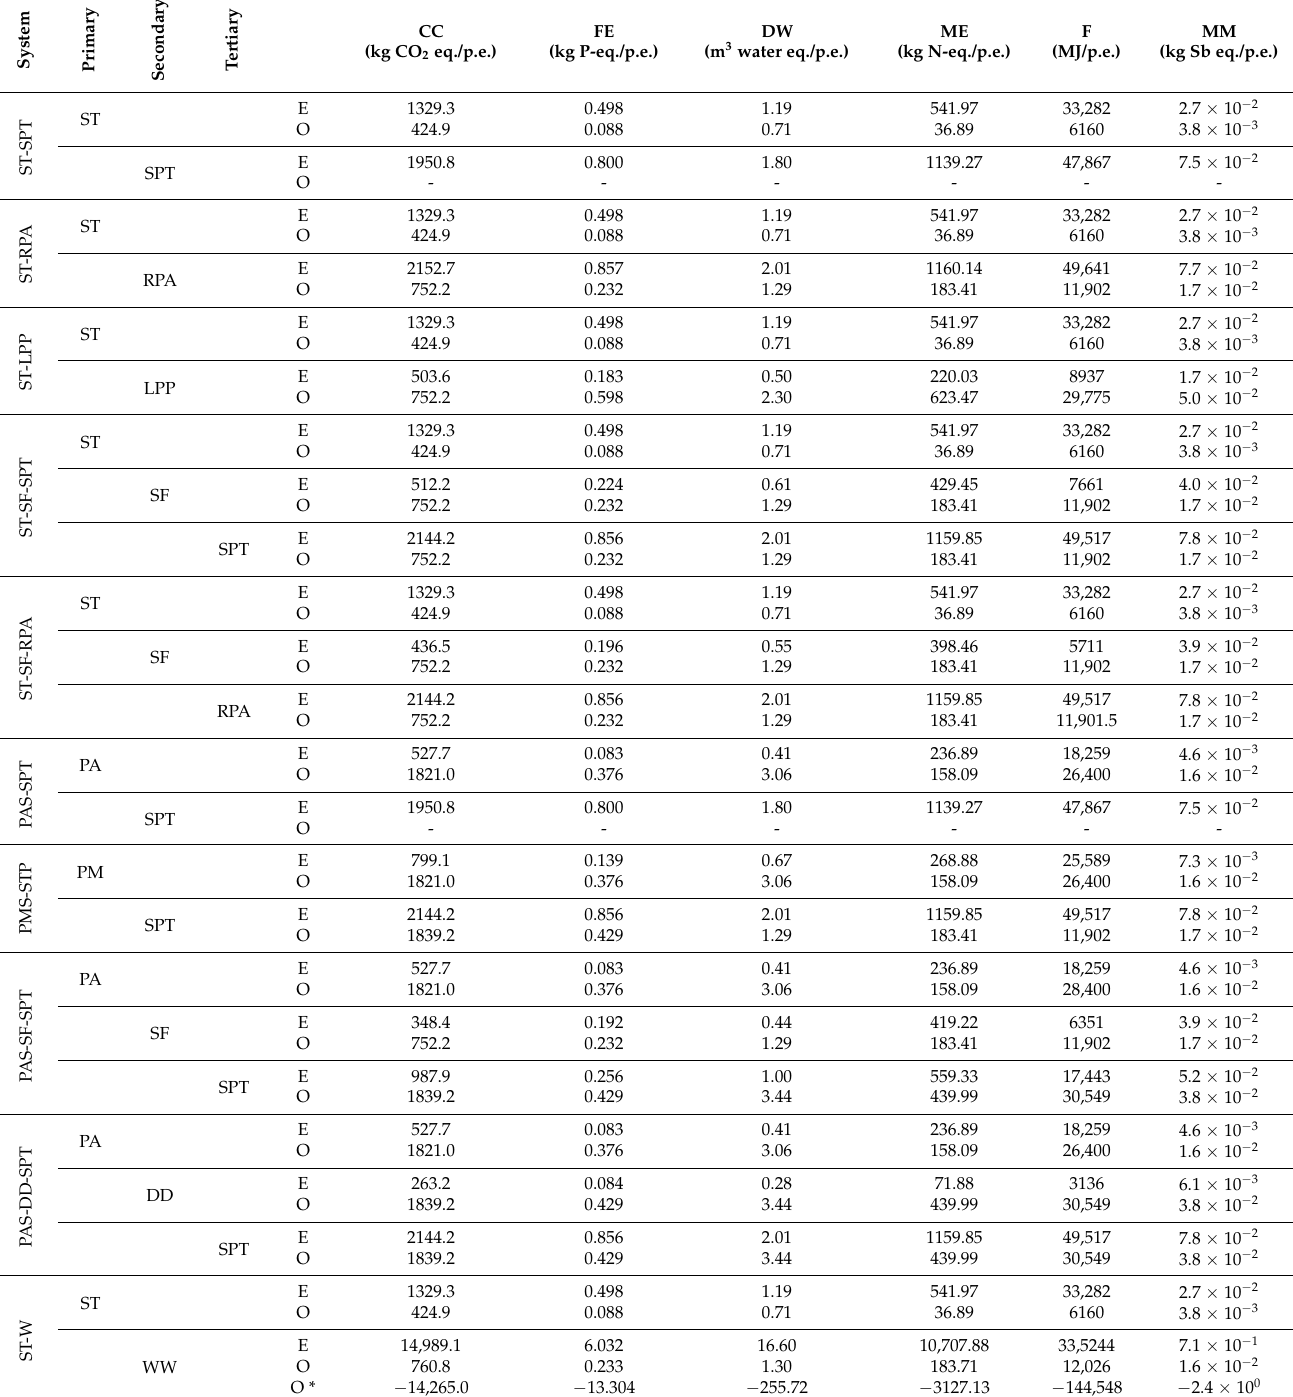
Table A3. A breakdown of the embodied (E), operational (O) and offset (O*) environmental burdens of each primary, secondary and tertiary treatment processes within the 10 on-site